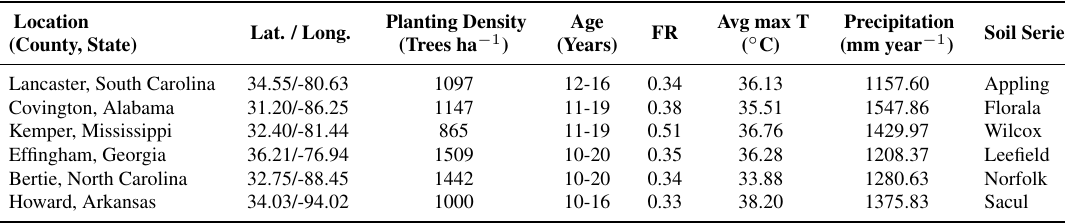
Table 3. Location (County, State), latitude / longitude, planting density, range of age, FR, average maximum temperature, average annual precipitation, and soil series of the sites used for independent validation of FR derived from site